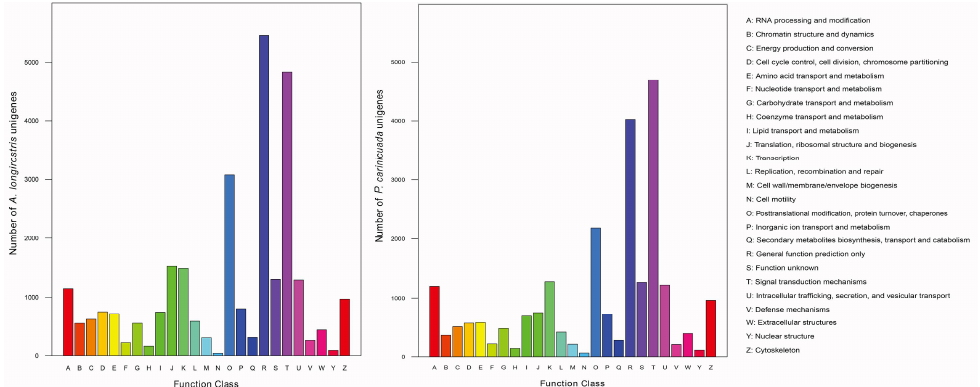
Figure 2. The KOG distribution of annotated genes in the eye transcriptomes of Alvinocaris longiros- tris and Palaemon carinicauda .